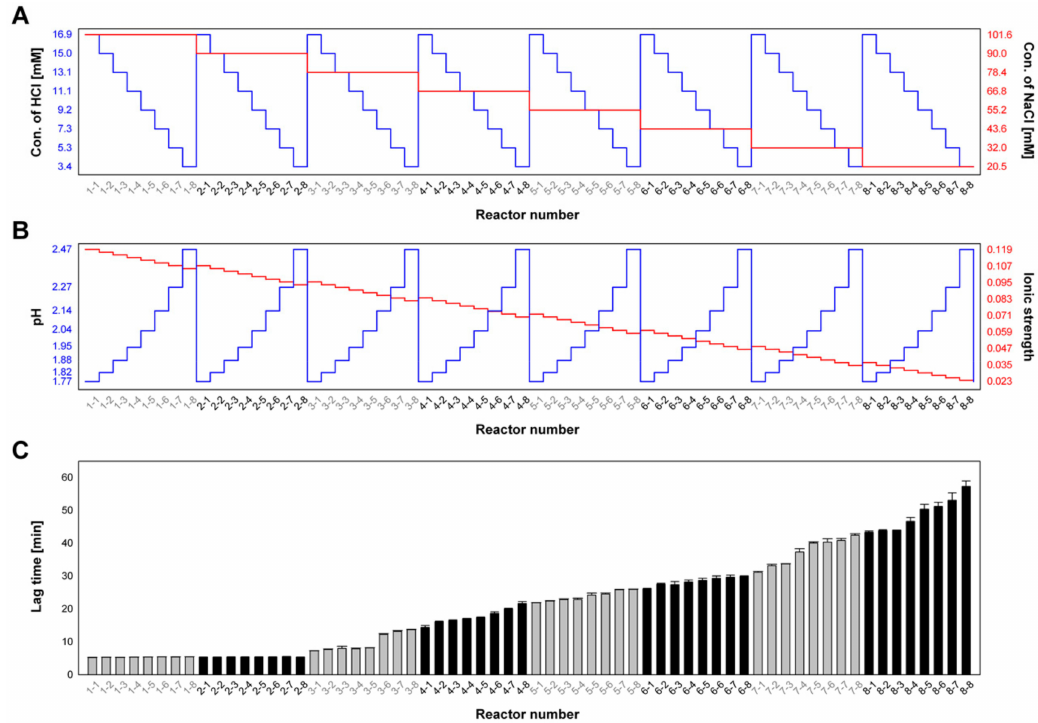
Figure 5. The combined e ff ect of concentrations of NaCl and HCl on insulin fibrillation. ( A ) Concentrations of HCl (blue) and NaCl (red), ( B ) calculated pH (blue) and ionic strength (red) values, and ( C ) measured lag times for the formation of insulin fibril ( n = 3) in the 64 incubation